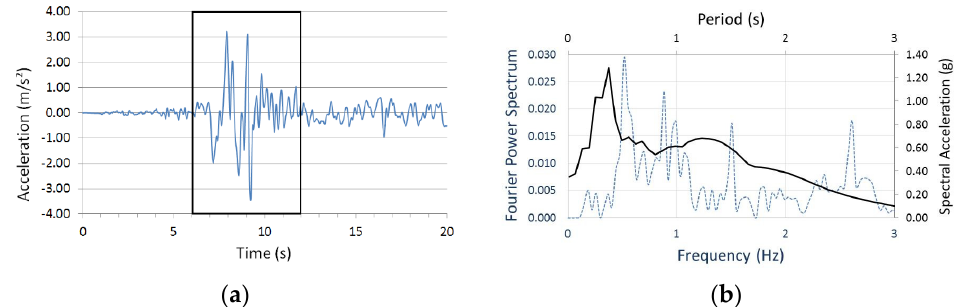
( b ) Figure 5. Schematic representation of the analyzed systems. ( a ) Cross section; ( b ) Plan view and location of the vertical reinforcements. 4. Input Motion A Nice earthquake (France) was used in the numerical model [54,55]. The character- istics of this 2001 earthquake are shown in Table 5. Table 5. The earthquake’s base motions considered. Earthquake